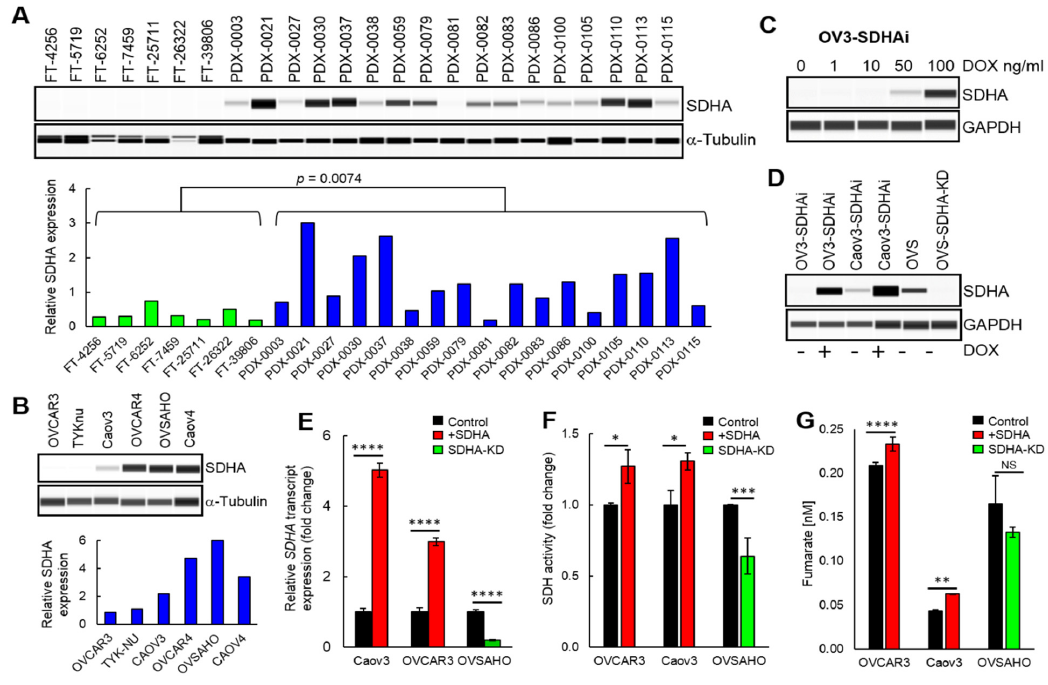
Figure 2. Evaluation of SDHA expression in ovarian cancer. ( A ) WES analysis of fallopian tubes “FT” or HGSOC PDX assayed for SDHA and α -Tubulin. Graph represents normalized quantification of SDHA protein expression using Compass for Simple Western Software. HGSOC PDXs showed significantly higher expression of SDHA than healthy FTs (Unpaired t -test). ( B ) WES analysis of ovarian cancer cell lines assayed for SDHA and α Tubulin. ( C ) Dose-dependent induction of SDHA by dox treatment for 24 h. ( D ) SDHA levels in cell lines conditionally overexpressing SDHA (SDHAi) following incubation with 100 ng/mL dox for 24 h. ( E ) The qRT-PCR analysis of SDHA transcript levels following induction of SDHA expression or SDHA knockdown (KD). Graph represents relative fold change in SDHA expression (normalized with β -actin expression). ( F ) Assessment of succinate dehydrogenase activity in ovarian cancer cell lines following SDHA induction or SDHA KD. Relative fold change in succinate dehydrogenase activity relative to control. ( G ) Levels of intracellular fumarate following SDHA induction or SDHA KD in ovarian cancer cell lines. Data are represented as mean ± SD, (unpaired t -test, **** = p < 0.0001 *** = p < 0.001 ** = p < 0.01 * = p < 0.05). The uncropped blots are shown in Figure